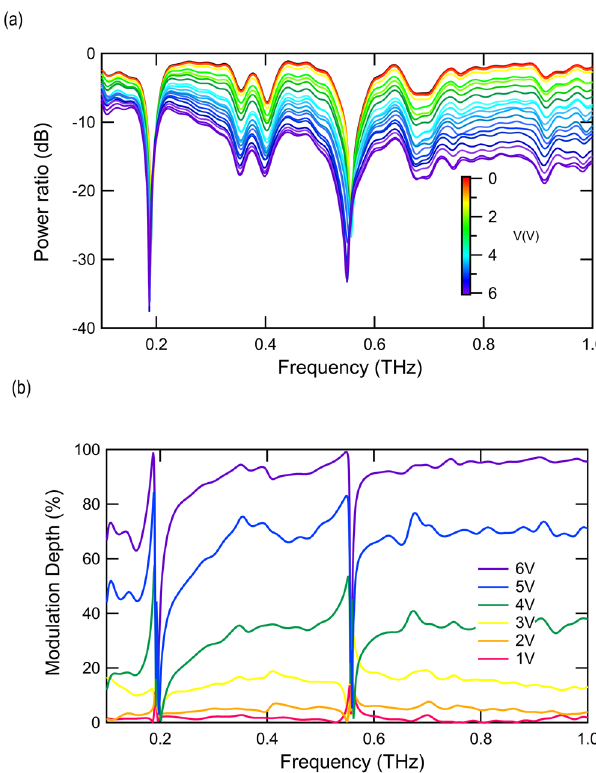
Fig. 6 Broadband tuning performance of the graphene/gold bilayer metasurface device. a Broadband frequency response of the absorber from 0 to 6 V. Frequency and amplitude tuning is observed for each resonance superimposed on a broadband modulation. b Broadband modulation depth of the graphene/gold bilayer absorber. Discontinuities are seen at resonant frequencies due to the relative frequency shift of these modes with respect to the applied fi